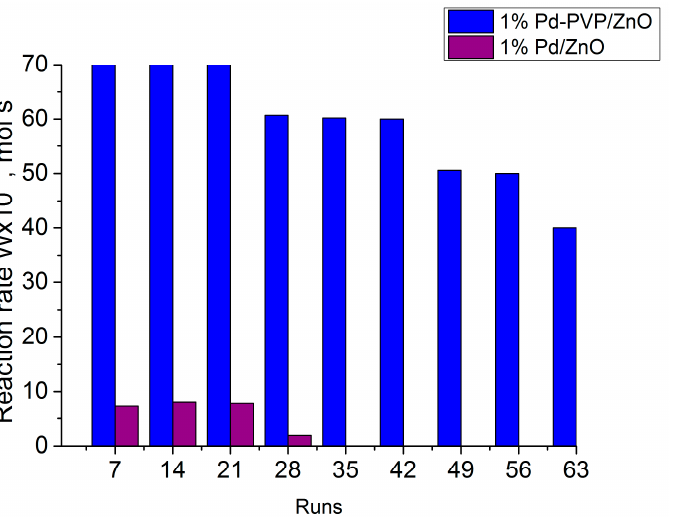
Figure 9. Consecutive hydrogenation of 3,7,11-trimethyldodecyn-1-ol-3 portions in the presence of 1%Pd-PVP/ZnO and 1%Pd/ZnO. Reaction conditions: T = 40 °C, P H2 = 1 atm, m cat = 0.05 g, solvent C 2 H 5 OH 0.25 mL, and C alkynol = 0.09 mol/L.